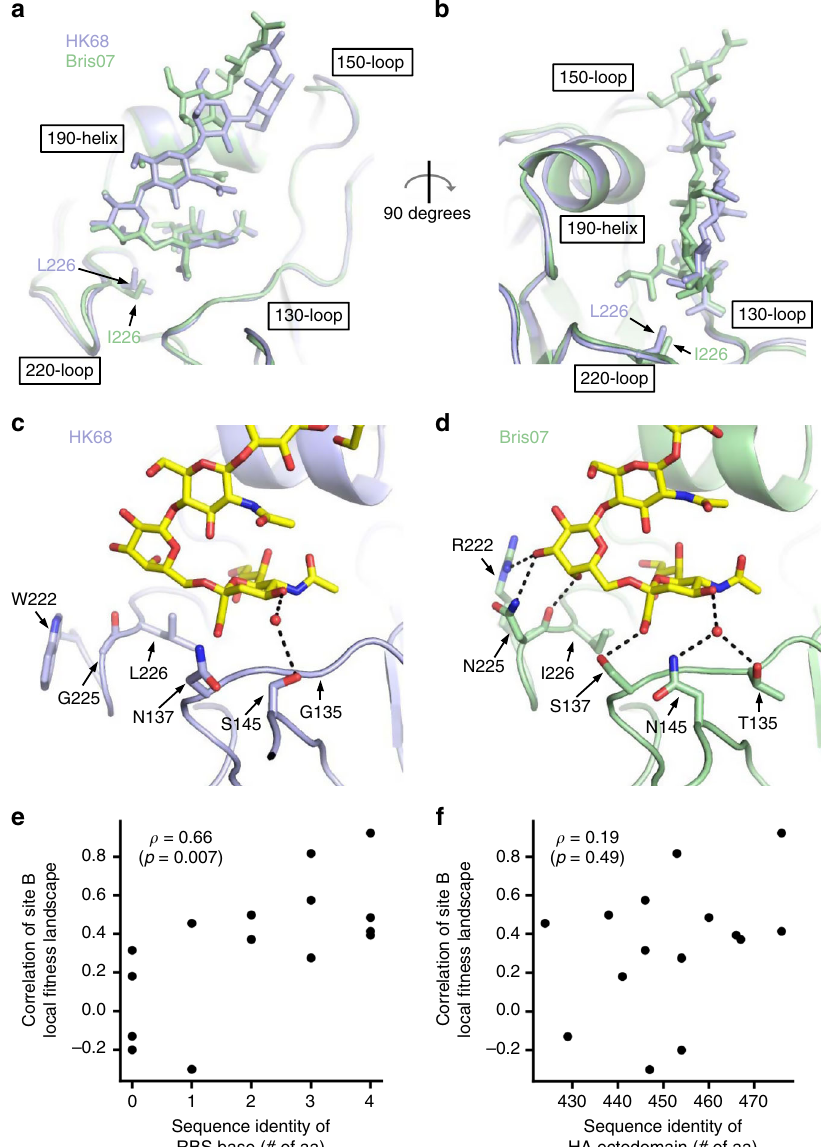
Fig. 5 Structural evolution of in fl uenza hemagglutinin receptor binding. a , b HA structures of Bris07 and HK68 in complex with 6 ′ SLNLN are aligned based on the receptor-binding subdomain (residues 117 – 265) 33 . a Front view of the HA RBS. b Side view of the HA RBS. HA is shown as cartoon representation. The side chain of HA1 residue 226 and 6 ′ SLNLN are shown in stick representation. c , d Interactions between HA and 6 ′ SLNLN at the base of c HK68 RBS or d Bris07 RBS are shown. Hydrogen bonds are represented by black dashed lines. Water molecules are shown as red spheres. 6 ′ SLNLN is colored in yellow and shown in stick representation. Side chains of interest are also shown in stick representation. The structure of Bris07 in complex with 6 ′ SLNLN is from PDB 6AOV 32 . e , f The relationship between the pairwise correlation of antigenic site B local fi tness landscape, which is quanti fi ed in Fig. 2c, and the pairwise amino acid sequence identity are shown. e Pairwise amino acid sequence identity was computed using sequences found in the RBS base, namely at residues 135, 137, 145, 222, 225, and 226. f Pairwise amino acid sequence identity was computed using the sequences of the entire HA ectodomain. e , f Spearman ’ s rank correlation ( ρ ) is indicated, with the p value ( P ) stated in the parentheses. The raw data of the pairwise amino acid sequence identity are shown in Supplementary Fig. 8. Source data are provided as a Source Data fi